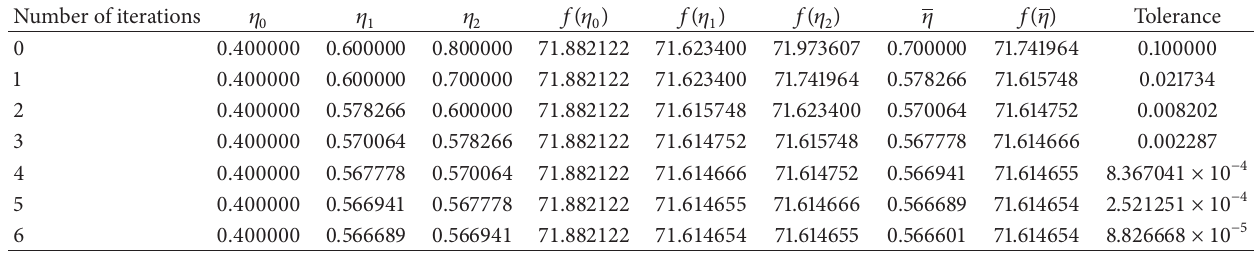
Table 1: The parabolic method in searching for the optimum solution.